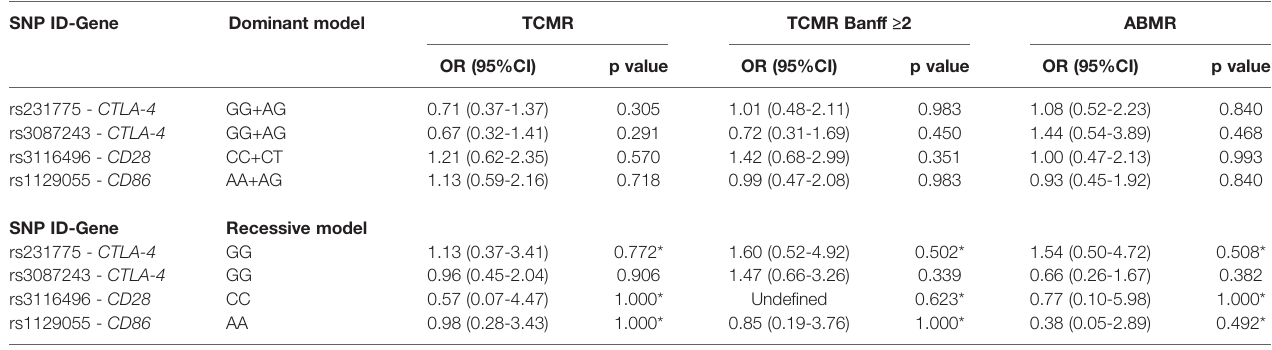
TABLE 2 | Univariate analysis for rejection in patients with Thymoglobulin induction therapy.